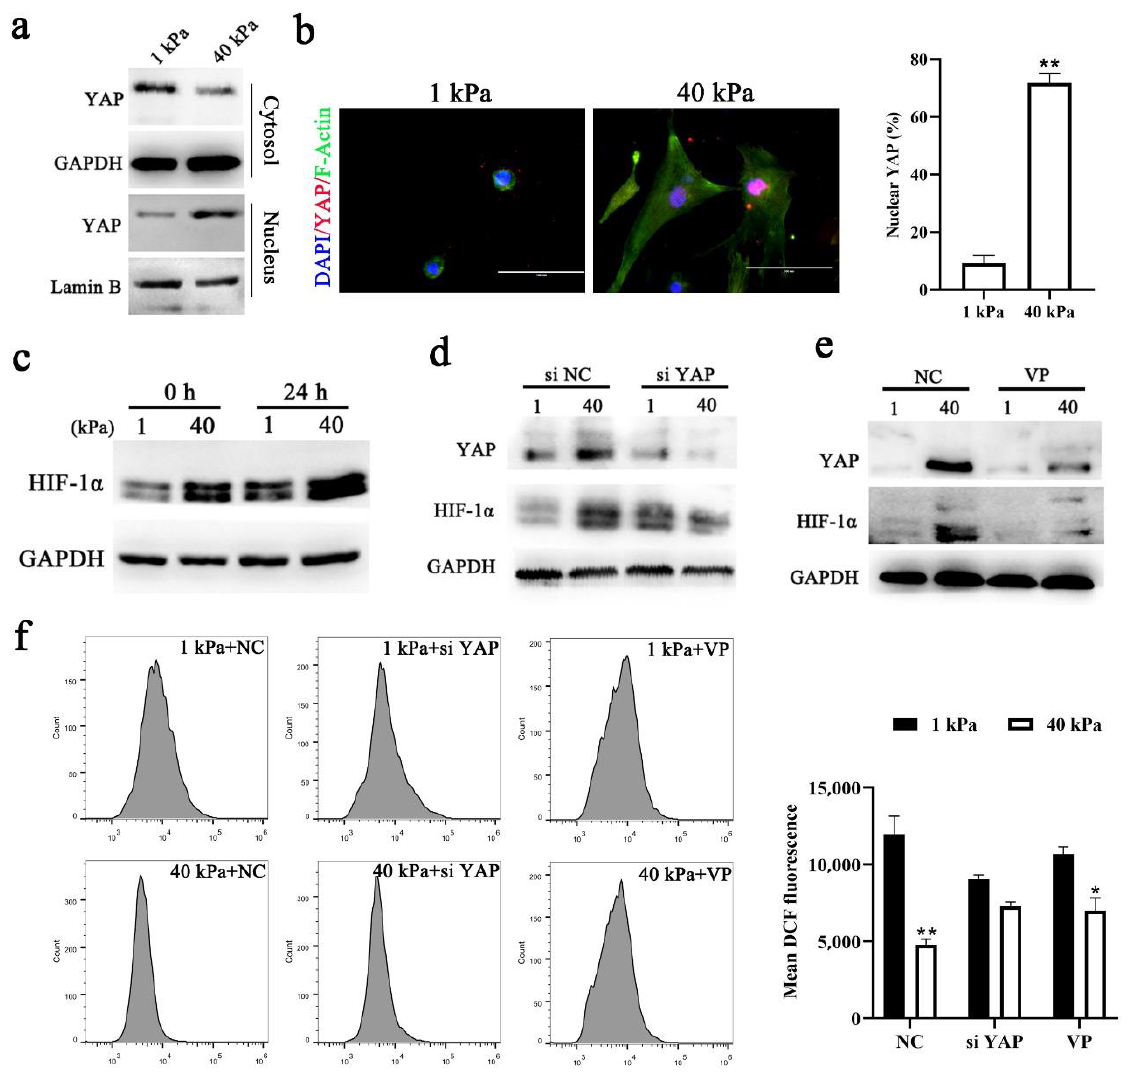
Figure 4. ECM stiffness regulates the activity of YAP/HIF-1 α and ROS production in ESCs . ( a ) Western blotting for YAP in nuclear and cytoplasmic protein fractions from ESCs plated on 1 kPa or 40 kPa fibronectin-coated hydrogels for 24 h, n = 3. ( b ) Confocal immunofluorescence images (left, n = 2) and quantification of nuclear and cytoplasmic subcellular localization (right, n = 15) of YAP in ESCs plated on hydrogels with different rigidities. Scale bar, 10 µ m. ( c ) Western blotting for HIF-1 α from decidualized cells plated on 1 kPa or 40 kPa hydrogels for 0 h and 24 h, n =